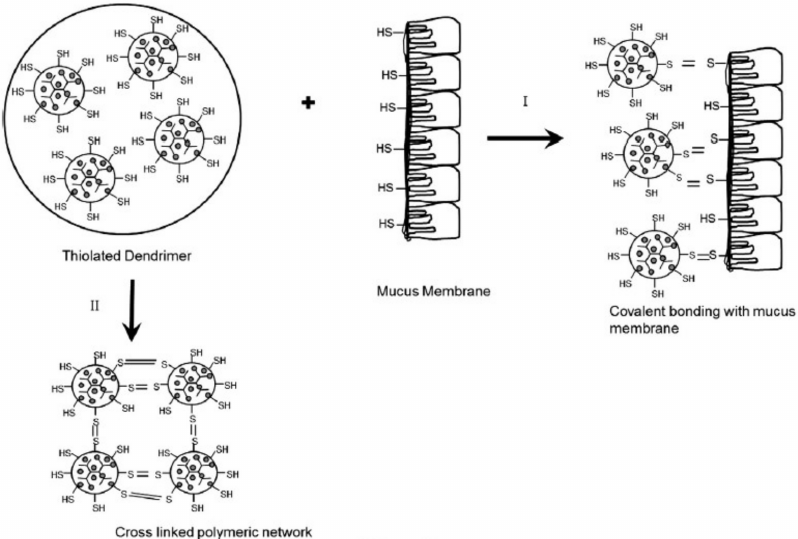
Figure 7. Schematic representation of muco-adhesiveness of thiolated dendrimers. ( I ) disulfide bond formation with glycoproteins of mucus membrane; ( II ) inter cross linking of thiolated dendrimers to form polymeric network. Reproduced with permission [19].